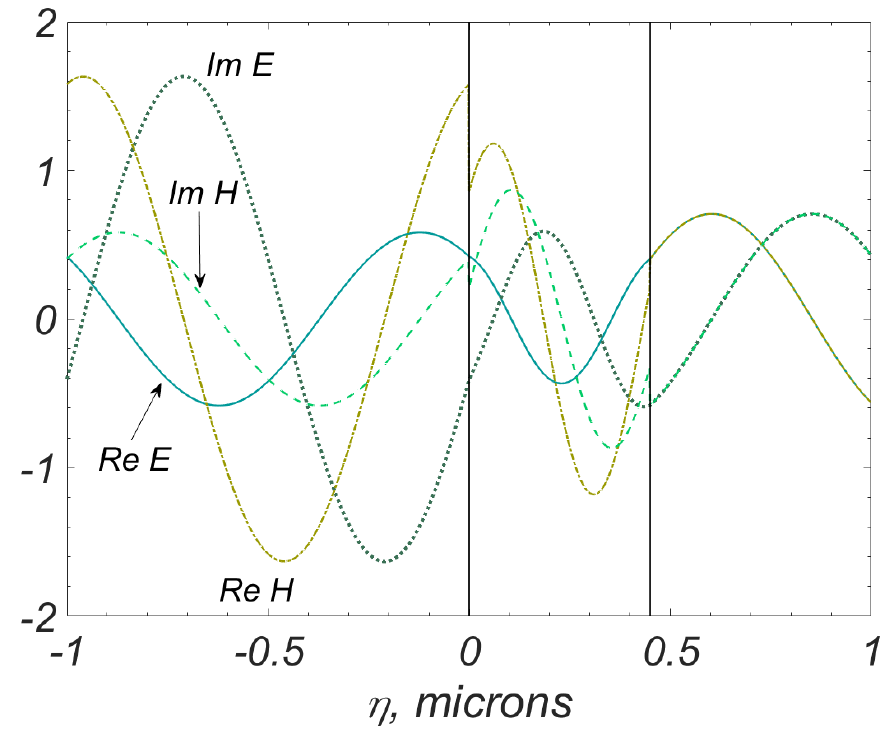
Figure 3. Fabry–Perot interferometer, s-polarization. Complex amplitudes of fields depending on the ray coordinate. Vertical lines are layer